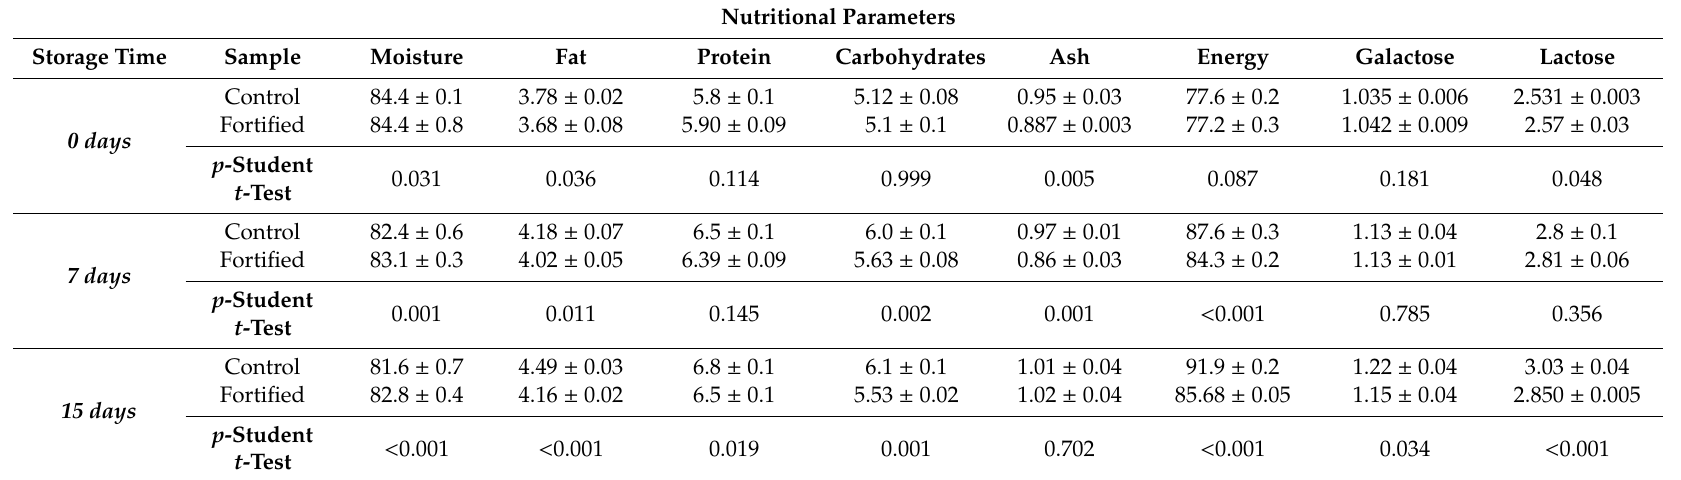
Table 4. Macronutrients, free sugars composition (g / 100 g), and energy value (kcal / 100 g) of the yogurts along shelf life. Nutritional